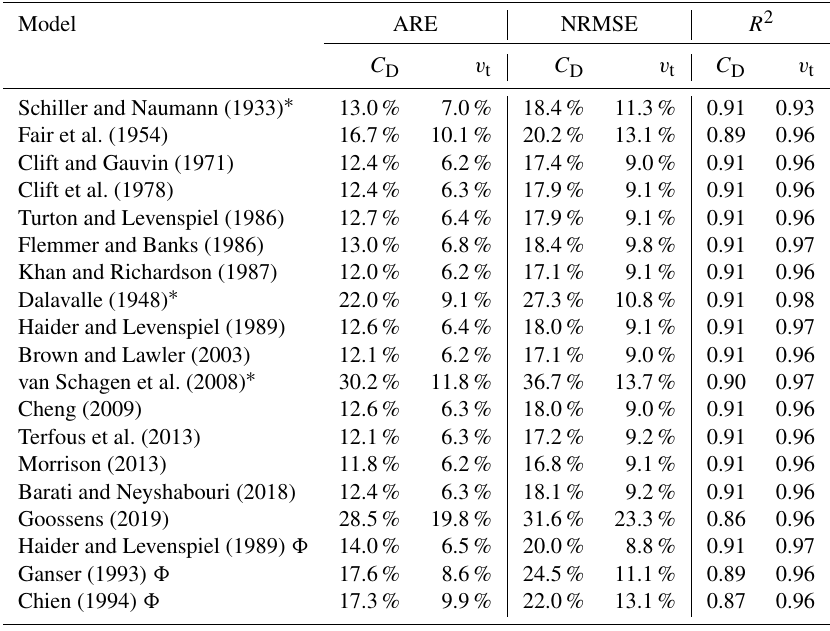
Table 3. Drag coefficient and terminal settling velocity prediction accuracy for individual terminal settling experiments ( N = 3629). Note: average relative error – ARE; normalised root mean square error – NRMSE; correlation coefficient – R 2 . The symbol (cid:56) indicates that the measured sphericity is included in the model.